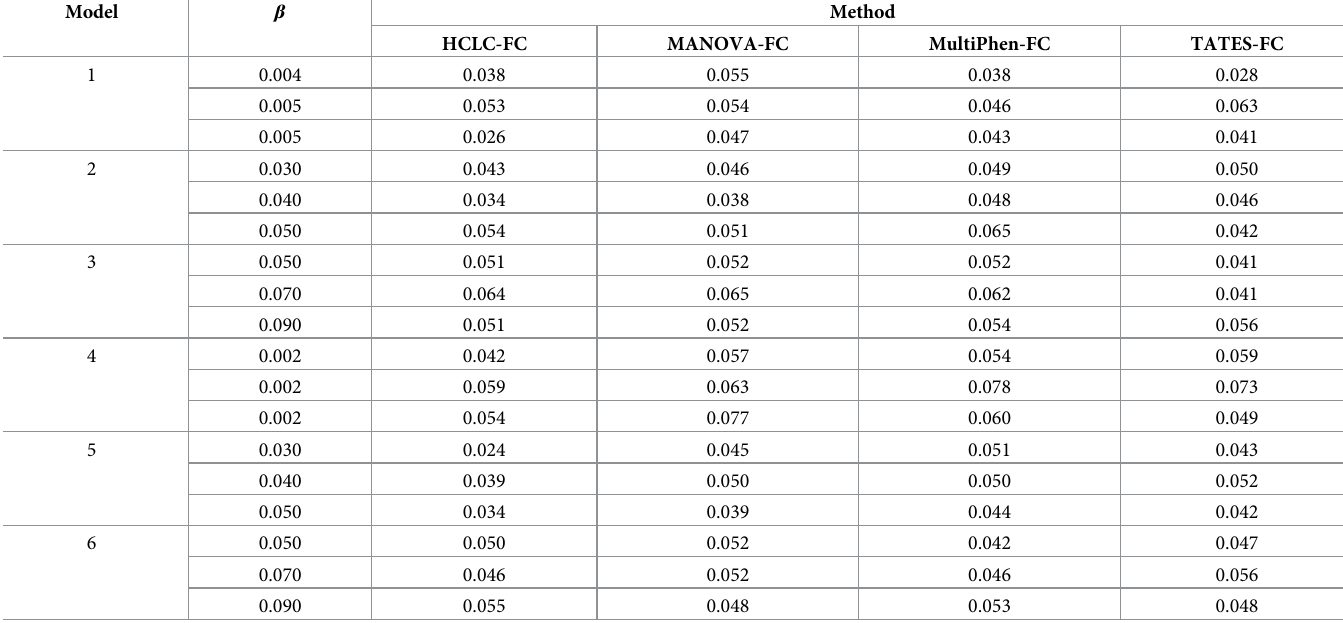
Table 2. The estimated FDR of the four tests under the six models for 2,000 phenotypes ( K = 2,000). MAF is 0.3. The sample size ( n ) is 4,000. ρ = 0.5. β is the effect size. FDR is evaluated using 200 replicated samples at a nominal FDR level of 5%. All estimated FDR are within the 95% confidence interval (0.0198,